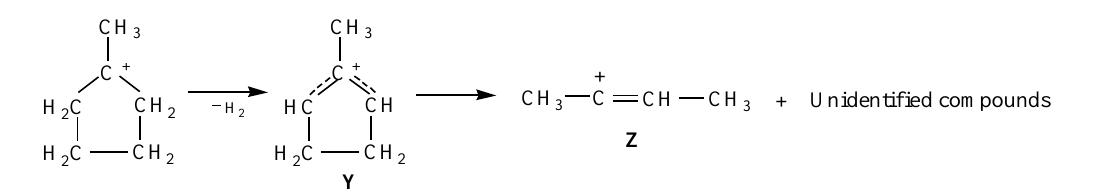
Scheme 1. Representation of the transition of saturated carbocation CH 3 - cyclo -C 5 H 9+ to an unsatu- rated carbocation in solutions.